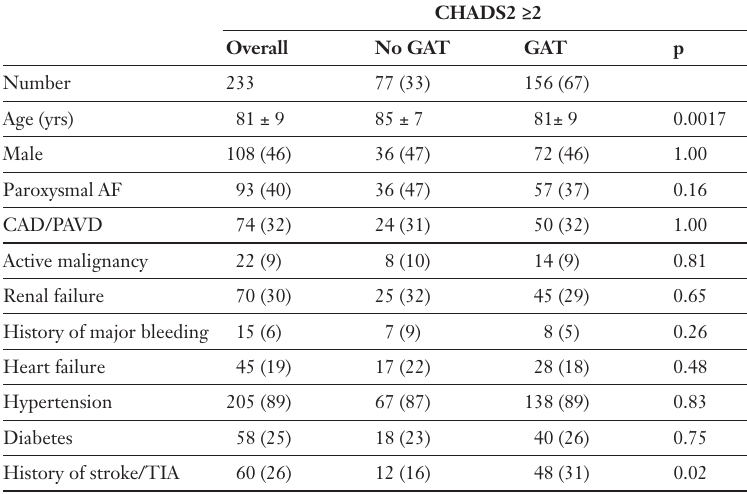
Table 2 Characteristics of patients at high thromboembolic risk between those without and those with guideline-adherent antithrombotic treatment (GAT).